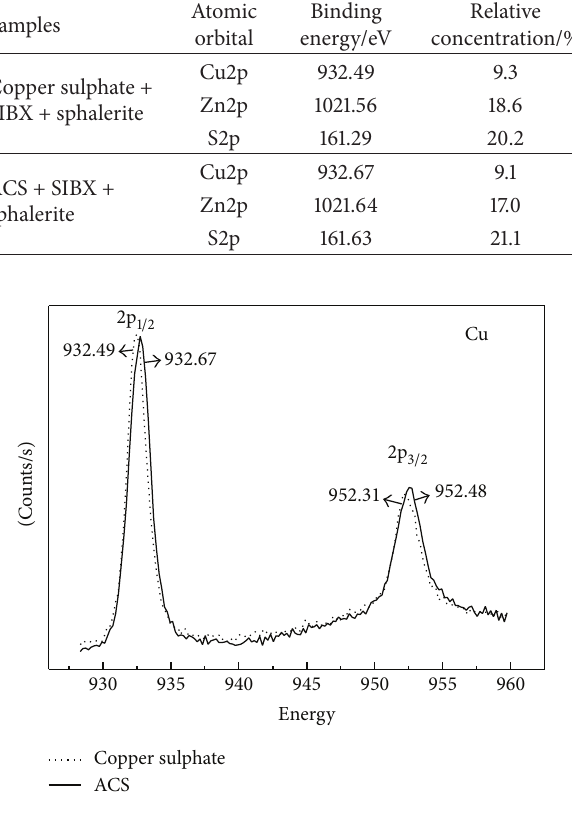
Figure 9: 2p spectra of Cu on sphalerite in the presence of different activator and collector butyl xanthate.